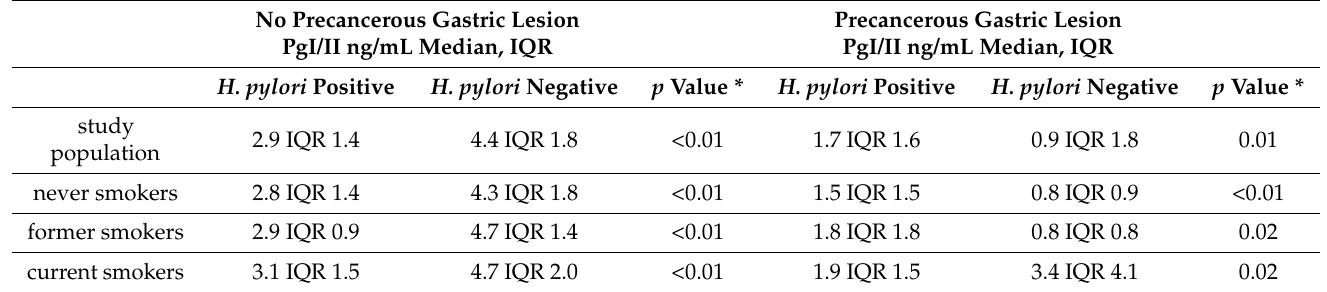
Table 3. Comparison of median Pg I/II ratio by smoking status and H. pylori presence for participants with and without precancerous gastric lesions.